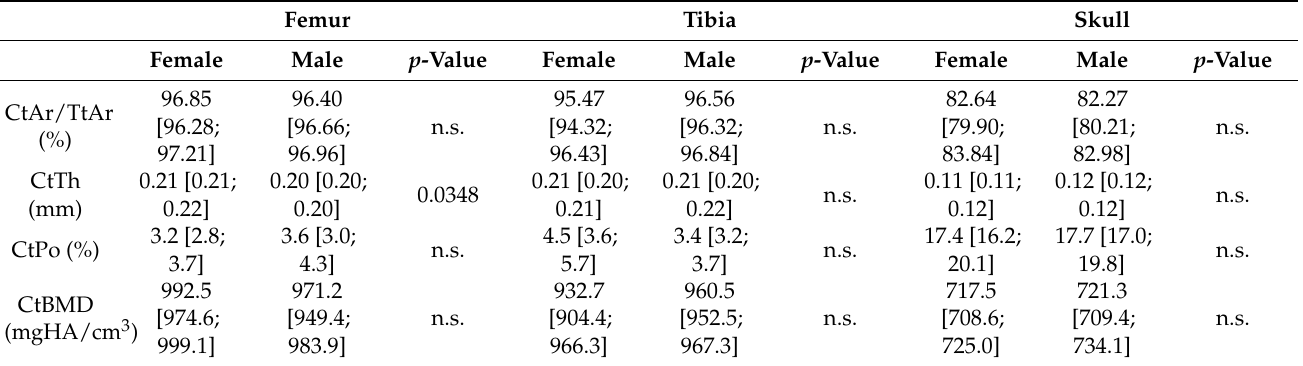
Table 2. Cortical bone mineral density and microarchitecture at three different skeletal sites in female (n = 10) and male (n = 10) C57BL/6J mice at 6-months of age.